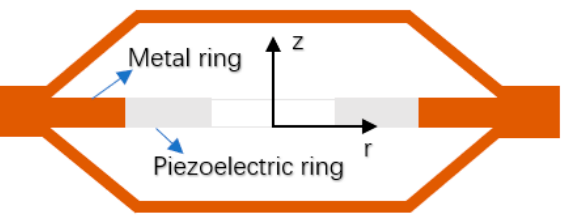
Figure 20. Influence of cavity depth. 050010001500 2000